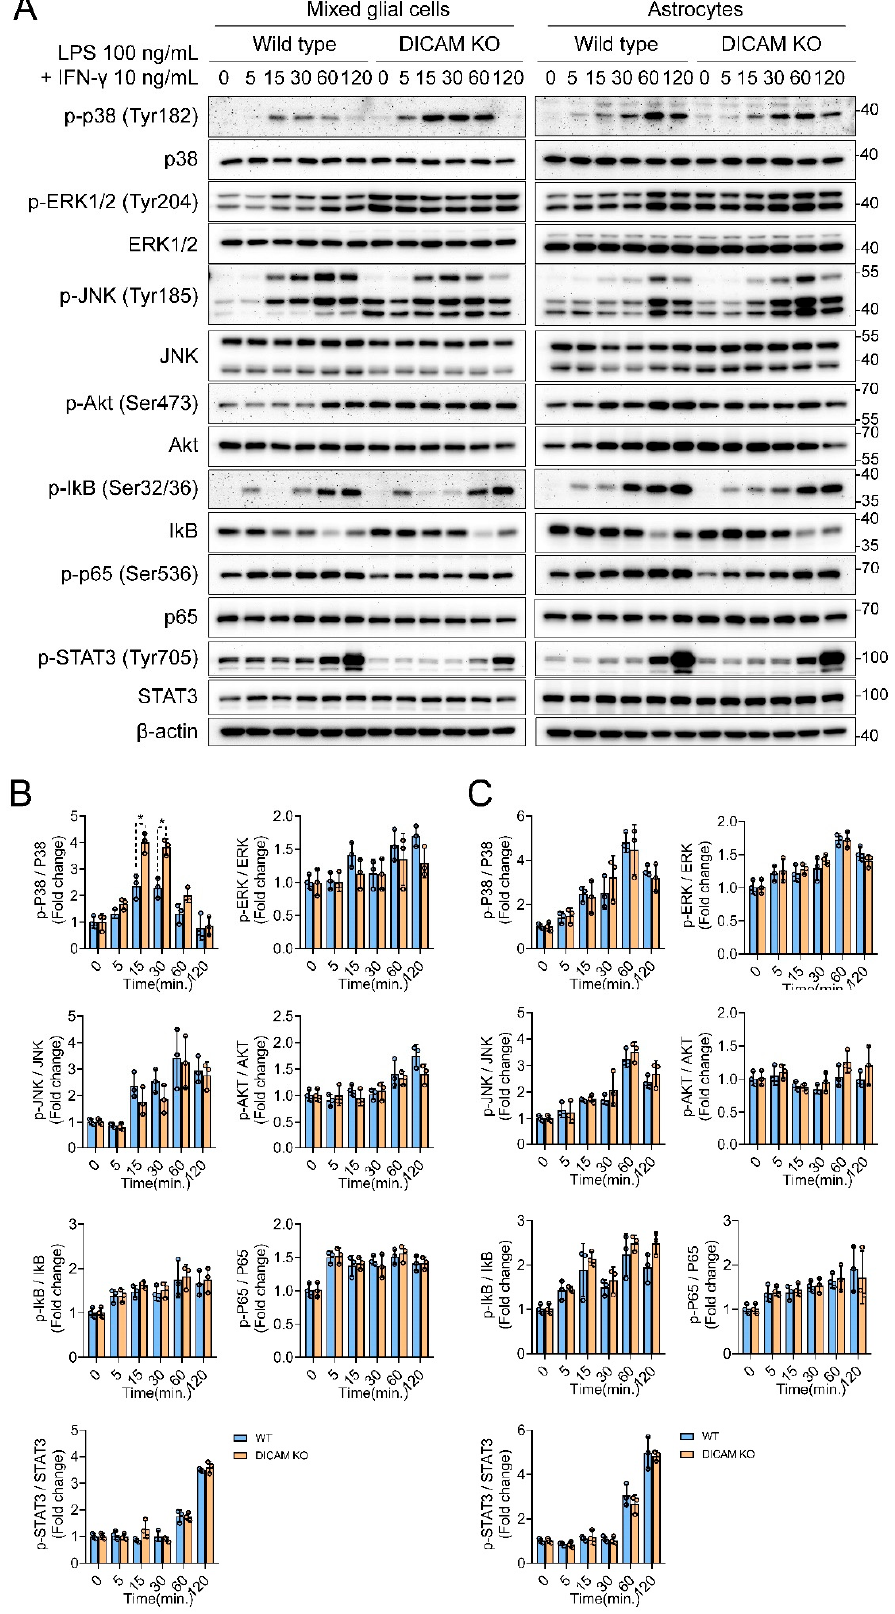
Figure 3. Deficiency of DICAM promotes p38 MAPK activation in primary mixed glial cell culture but not in astrocytes. ( A ) Starved primary mixed glial cells and astrocytes derived from DICAM